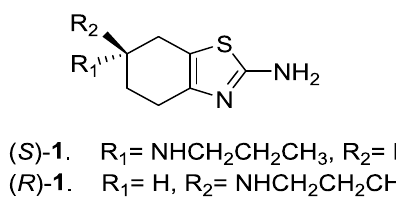
Figure 1. Structures of pramipexole ( S )- 1 and dexpramipexole ( R )- 1 .